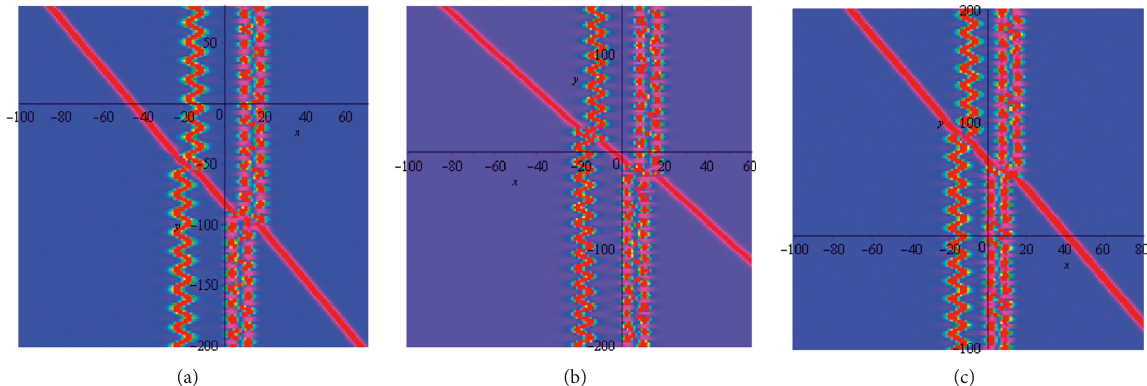
Figure 24: Plots of equation (86) by taking ϕ (c) f 3.